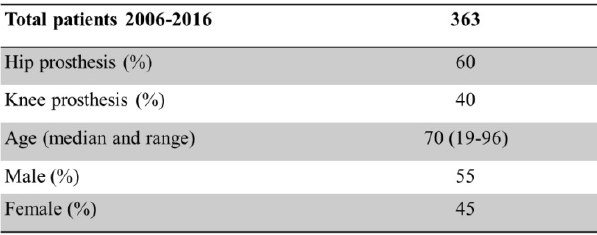
Table 1. Patients' demographic characteristics.